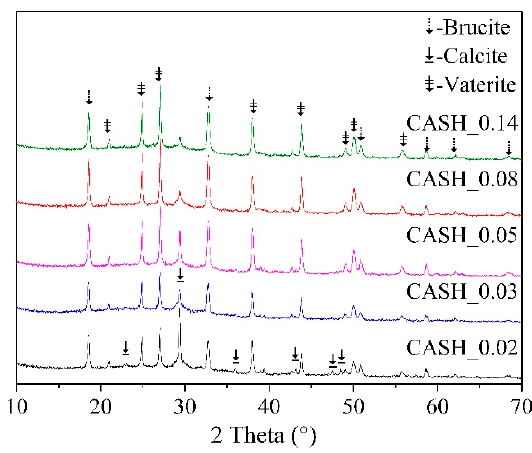
Figure 6. XRD analysis of C-(A)-S-H after carbonation for 28 days. Table 4. The e ff ect of Al / Si ratio on the content of calcite and vaterite.